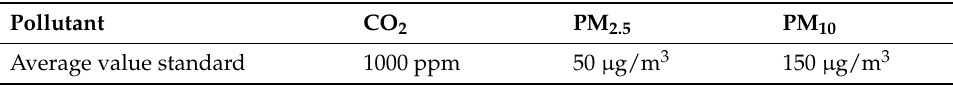
Table A2. Chinese indoor air quality standards for the elderly.